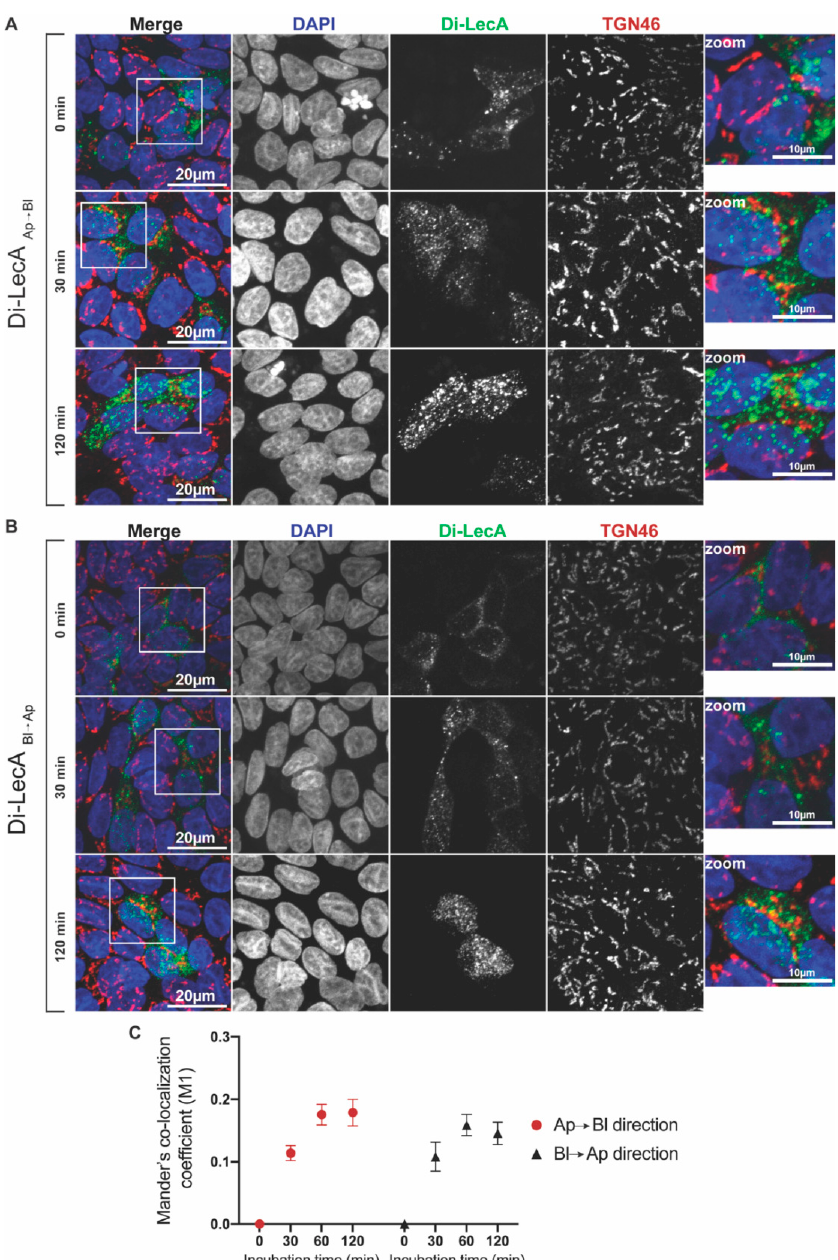
Figure 2. Co-localization analysis of Di-LecA with the trans-Golgi network marker TGN46. ( A ) Fluorescent Di-LecA (green) was pre-bound to the Ap cell surface of Gb3-positive MDCK cells at 4 °C for 30 min. After washing away unbound lectin, cells were shifted to 37 °C for up to 120 min to allow endocytosis and intracellular trafficking from Ap to the Bl side. After fixation and permeabilization, nuclei were stained with DAPI (blue), and TGN46 was stained with a primary antibody, followed by incubation with the corresponding secondary antibody (red). Images were acquired via confocal microscopy, and representative maximum intensity projections are presented (scale bar: 20 µm; scale bar in the zoom: 10 µm). ( B ) Fluorescent Di-LecA was pre-bound to the Bl cell surface and intracellular trafficking from Bl to the Ap side through the TGN was analyzed. Precisely the same experimental conditions were applied as described in ( A ). ( C ) Mander’s M1 co-localization coefficient between Di-LecA and TGN46 was calculated via the Coloc-2 plugin in ImageJ for different time points (0–120 min) of transport in the Ap → Bl and Bl → Ap directions. For each time point, the included individual cell number n was greater or equal to 30. The error bars represent the